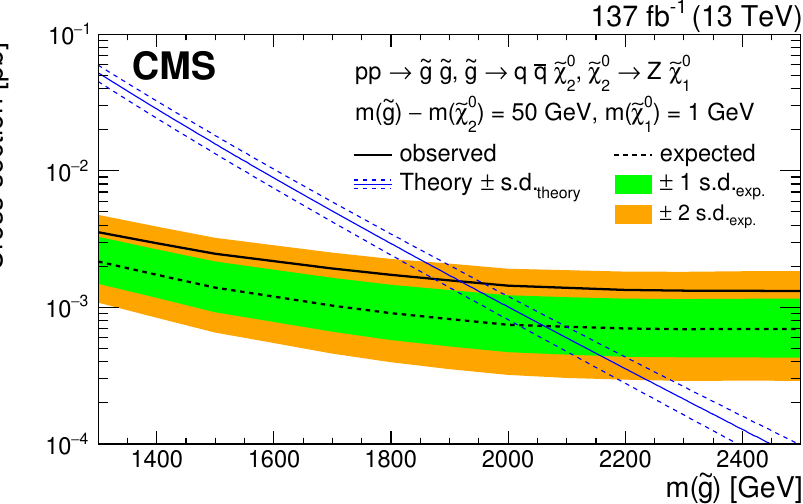
Figure 9 . The 95% CL upper limit on the production cross section for the T5ZZ signal model as a function of the gluino mass. The solid black curve shows the observed exclusion limit. The dashed black curve presents the expected limit while the green and yellow bands represent the (cid:6) 1 and (cid:6) 2 standard deviation uncertainty ranges. The approximate-NNLO+NNLL cross sections [41{45] are shown in the solid blue curve while the dashed blue curves show their theoretical uncertainties